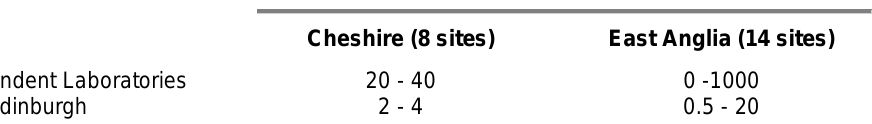
Concentrations from Different 3